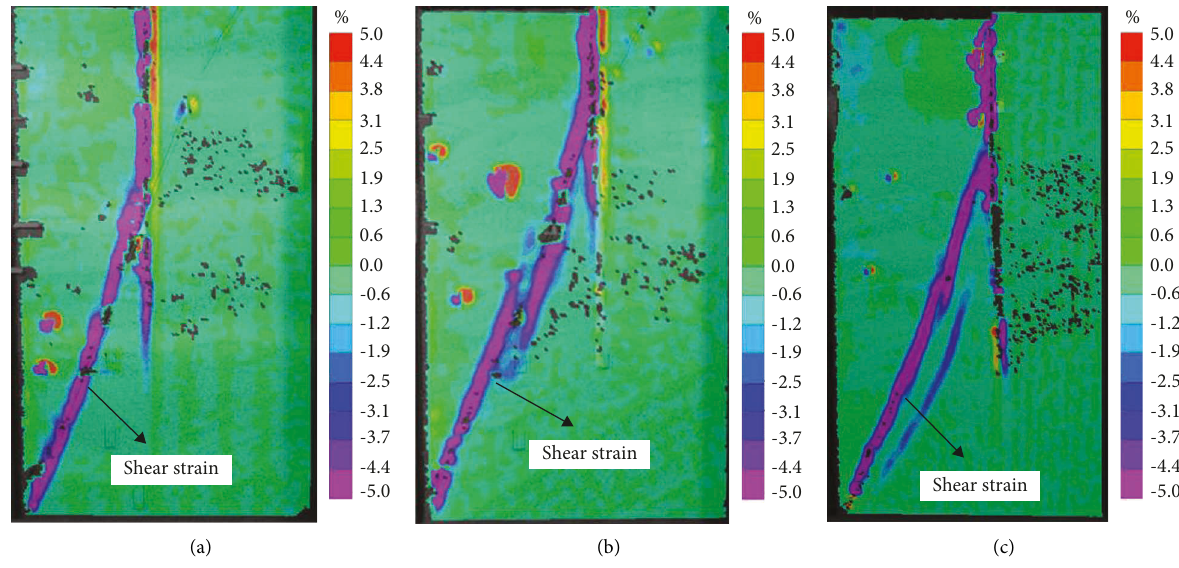
Figure 15: The shear strain in samples (a) M4, (b) M5, and (c)